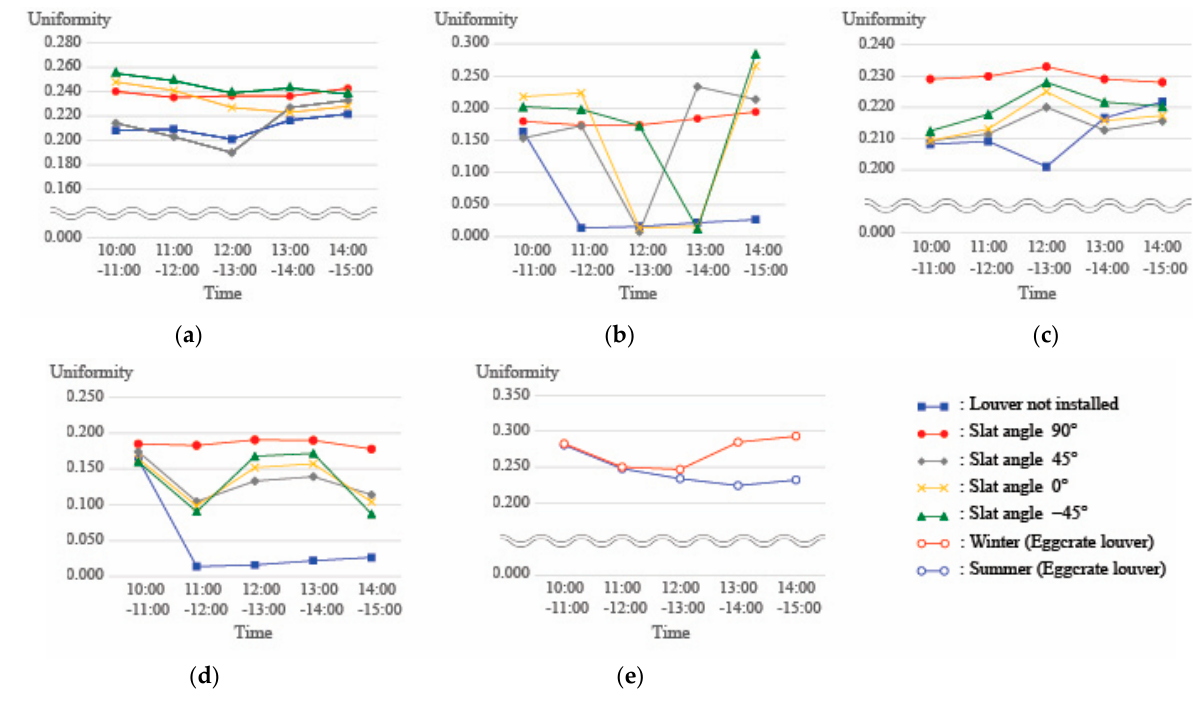
Figure 9. Results of analyzing the indoor uniformity according to Cases 1, 2, 3, and 4. ( a ) Vertical louver in summer. ( b ) Vertical louver in winter. ( c ) Horizontal Vertical louver in summer. ( d ) Horizontal Vertical louver in winter. ( e ) Eggerate louver. Table 5. Optimal slat angles for each period in Cases 2 and 3 to improve indoor uniformity.